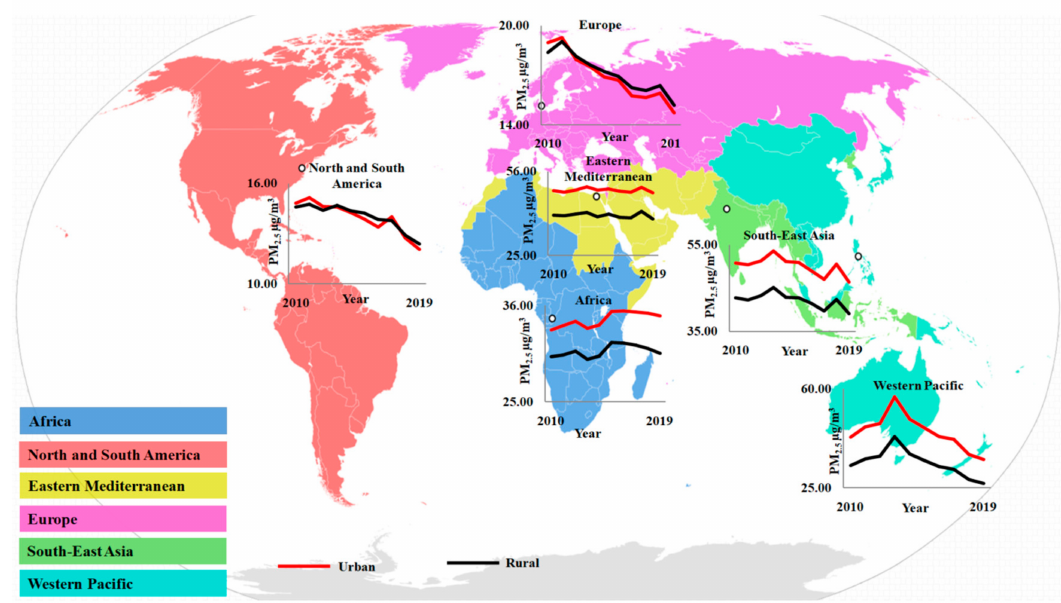
Figure 2. Graphical representation showed the PM 2.5 concentration level in urban and rural areas from 2010 to 2019 (https://www.who.int/data/gho/data/themes/air-pollution/who-air-quality- database, accessed on 11 November 2022). The representation shows that the rural area level of concentration is lower compared to that in the urban area in most